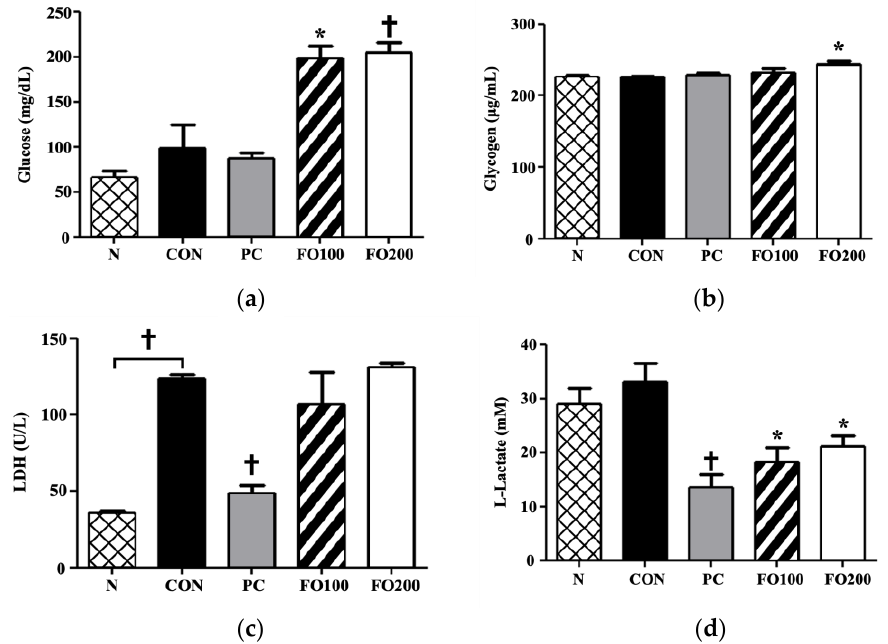
Figure 10. Changes in serum ( a ) glucose and liver ( b ) glycogen, ( c ) LDH and ( d ) L-lactate were measured following administration of 100 and 200 μg/mL of FO. Each bar represents the mean ± SD. A one-way ANOVA test was carried out to determine significant differences (* p < 0.05 vs. Control, † p < 0.001 vs. Control).